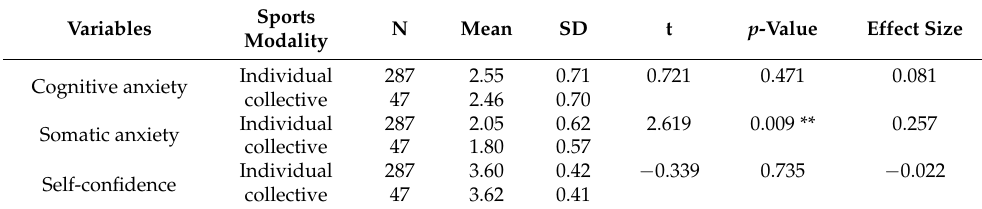
Table 5. Differences between individual and collective